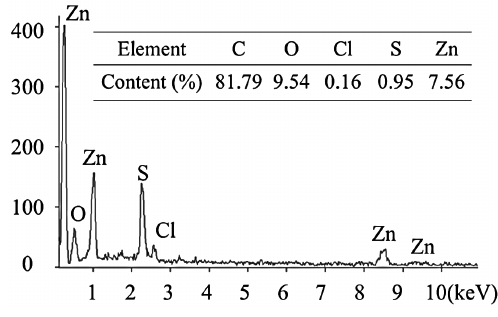
Figure 3. EDS spectrum of ZCF.